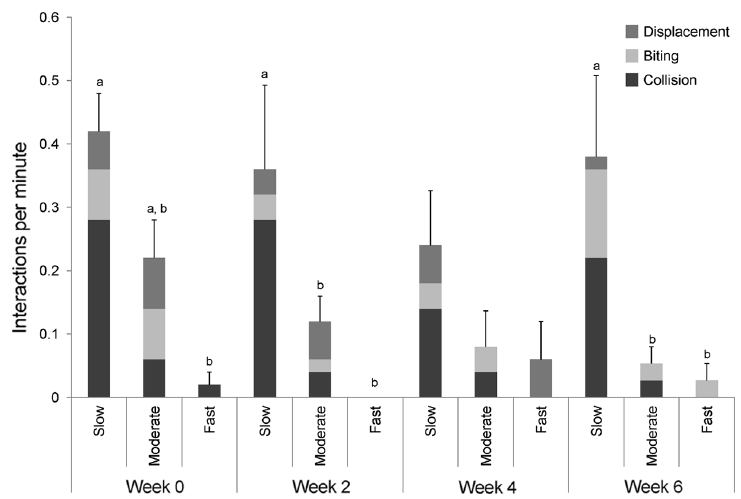
Fig. 2. Mean of interacting behaviours per minute in fish at 3 different water current velocities (slow, 0.2 body length [BL] s −1 ; moderate, 0.8 BL s −1 ; and fast,1.5 BL s −1 ) over 6 wk. Error bars represent SE of total occurrences. Lowercase letters denote significant difference between current velocities based on cumulated interactions (p < 0.05)